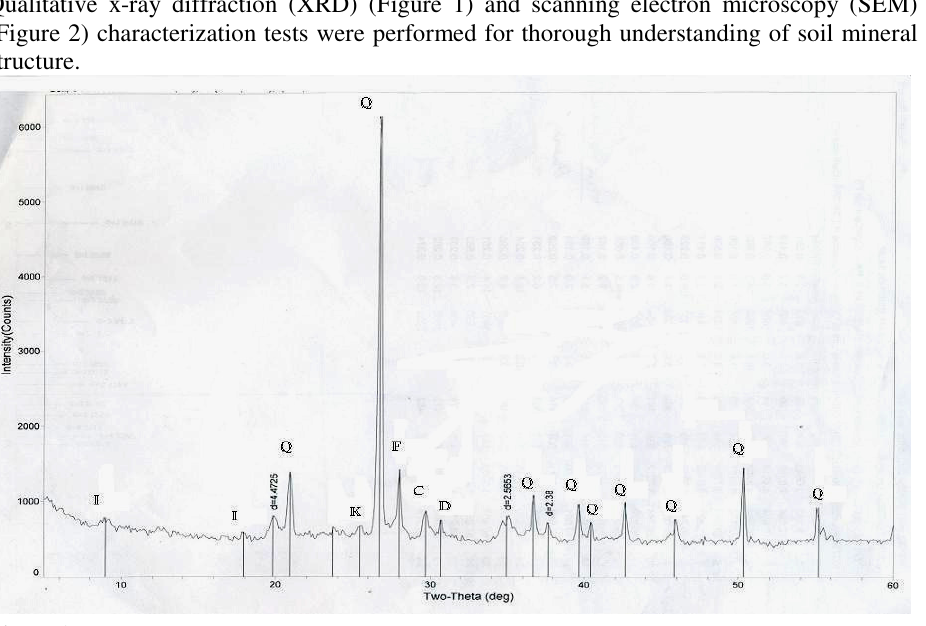
Figure1. XRD pattern of virgin soil Q-Quartz; F-Feldspar; C-Calcite; D-Dolamite; I-Illite;